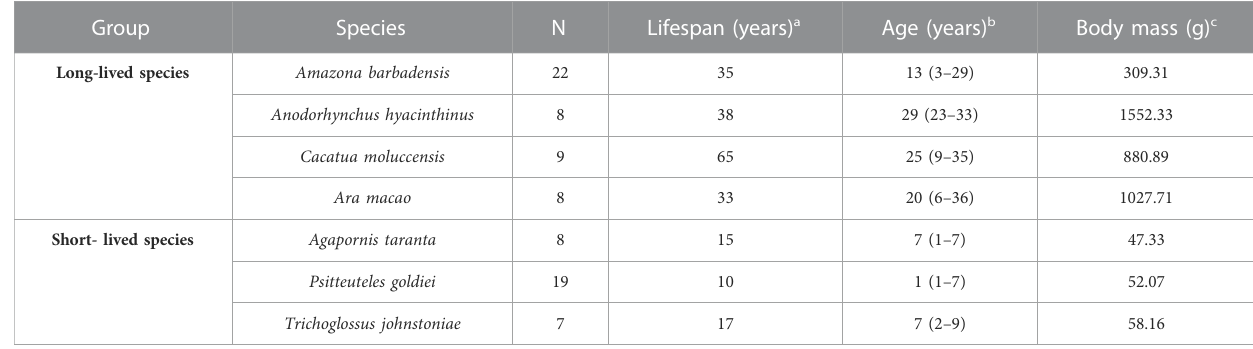
TABLE 1 Characteristics of long-lived and short-lived species of Psittacidae included in this study. Group